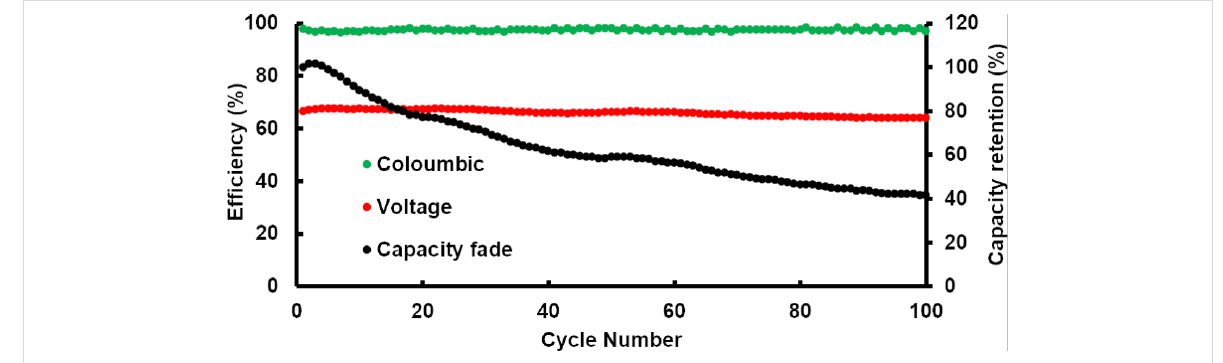
Figure 7: Evolution of efficiency and capacity retention during long-term cycling with a N 2 -plasma-treated sample.